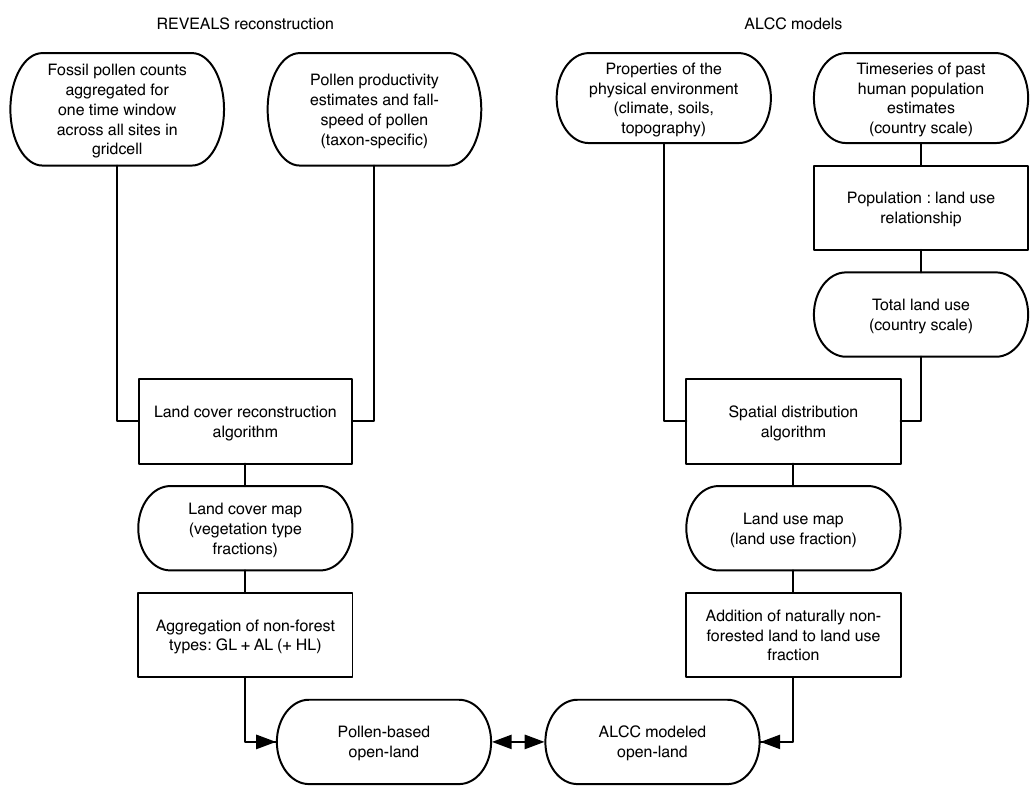
Figure 1. Inputs and outputs (rounded rectangles) and processes represented (rectangles) in the REVEALSand anthropogenic land cover change (ALCC) modeling methods. Abbreviations: grassland (GL), agricultural land (AL, cereals), heathland (HL, Calluna vulgaris ). See Section 2.1 for the pollen taxa included in